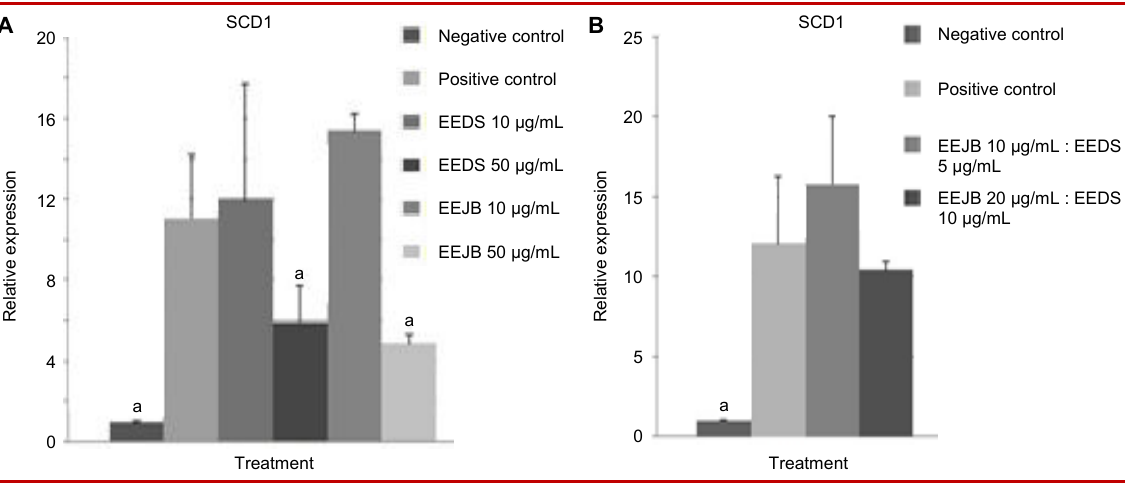
Figure 2: Relative expression of adipogenesis-related gene, C/EBP (cid:450) in 3T3-L1 cells. (a) Effects of single ethanol extract of Detam 1 soybean (EEDS) or ethanol extract of Jati belanda leaves (EEJB) treatments in concentration of 10 µg/mL and 50 µg/mL; (b) Ef- fects of combination of ethanol extract of Jati belanda leaves and ethanol extract of Detam 1 soybean treatments in concentration of 10 µg/mL, 5 µg/mL and 20 µg/mL, 10 µg/mL (*p<0.05, significant compared to positive control, Duncan post-hoc